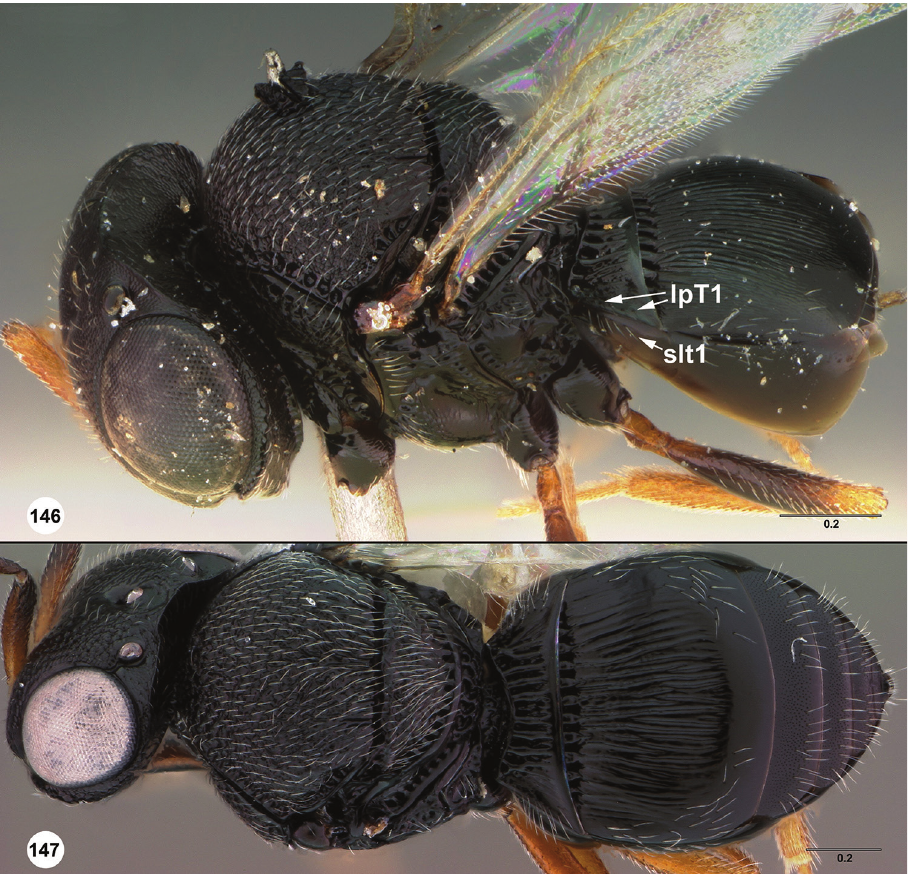
Figures 146–147. Trissolcus saakowi 146 female lectotype (NHMW 0003), head, mesosoma, meta- soma, dorsolateral view 147 female (USNMENT00977544), head, mesosoma, metasoma, dorsal view. Scale bars in millimeters.